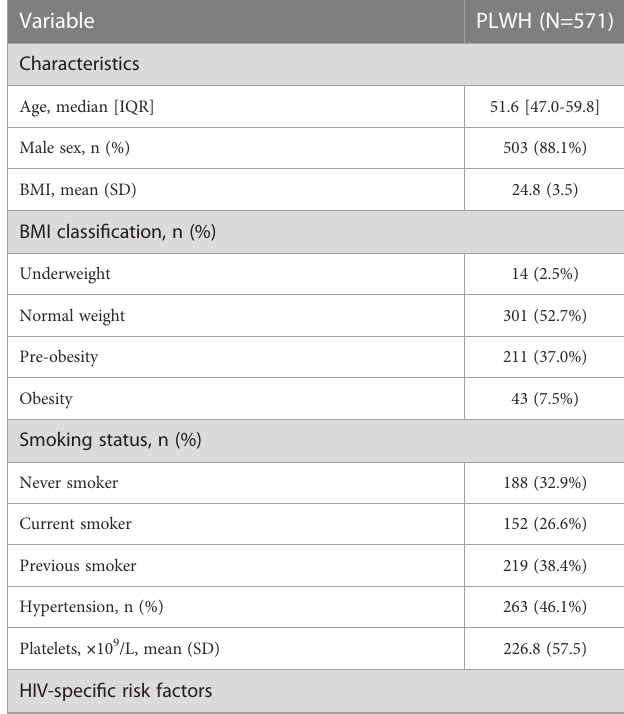
TABLE 1 Participant characteristics, HIV-speci fi c risk factors, and concentrations of the